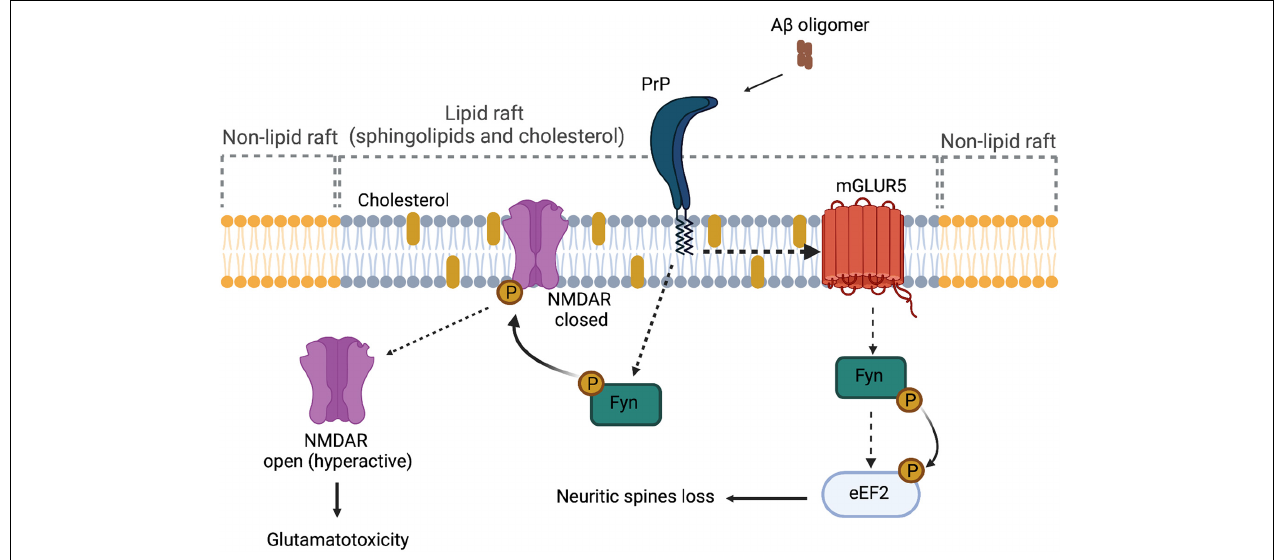
FIGURE 2 | PrP C as a signal transducer. In the context of Alzheimer’s disease, the interaction between A β oligomers and PrP C affects receptors located on the plasmatic membrane, such as NMDAR and mGluR5. In the case of NMDAR, because of the interaction of A β oligomers and PrP C , the receptor is phosphorylated through Fyn, hyperactivating the channel and causing glutamatotoxicity. In the case of mGluR5, there is a direct interaction between PrP C and the receptor, causing the activation of Fyn kinase and promoting the phosphorylation of eEF2 and the consequent loss of neuritic